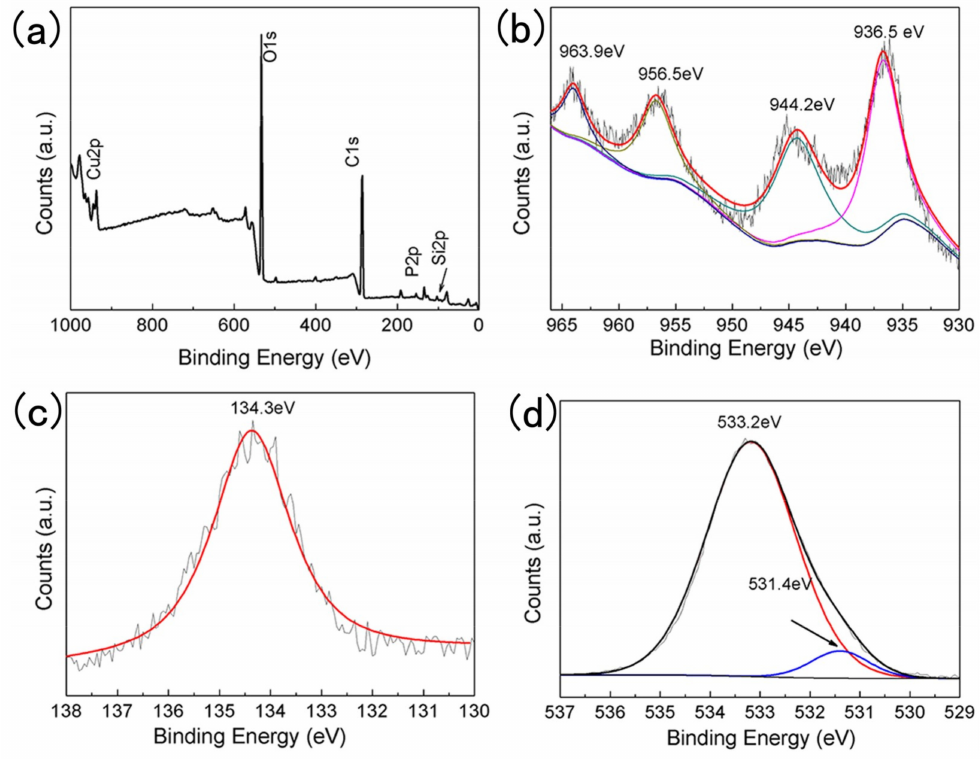
Figure 5. X-ray photoelectron spectroscopy spectra of the coated cotton fabrics, ( a ) survey spectrum; ( b ) Cu 2p; ( c ) P 2p; and ( d ) O